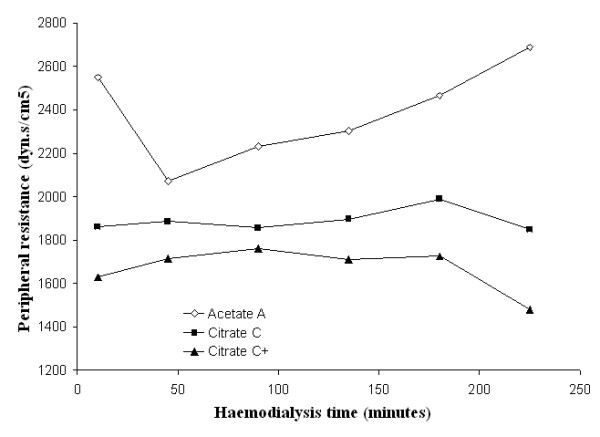
Peripheral resistance. Peripheral resistance as a function of the haemodialysis time using, respectively, acetate (A) (empty diamonds), calcium uncorrected citrate (C) (black squares) and calcium supplemented citrate dialysate (C+) (black triangles).